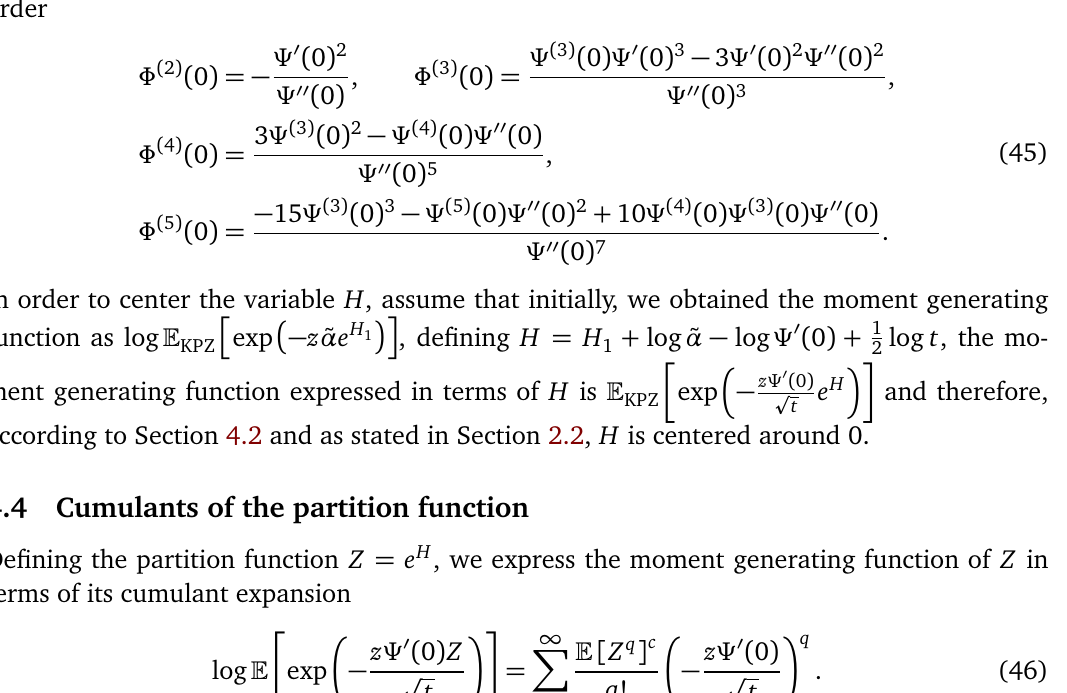
or z = − ζ , one needs c